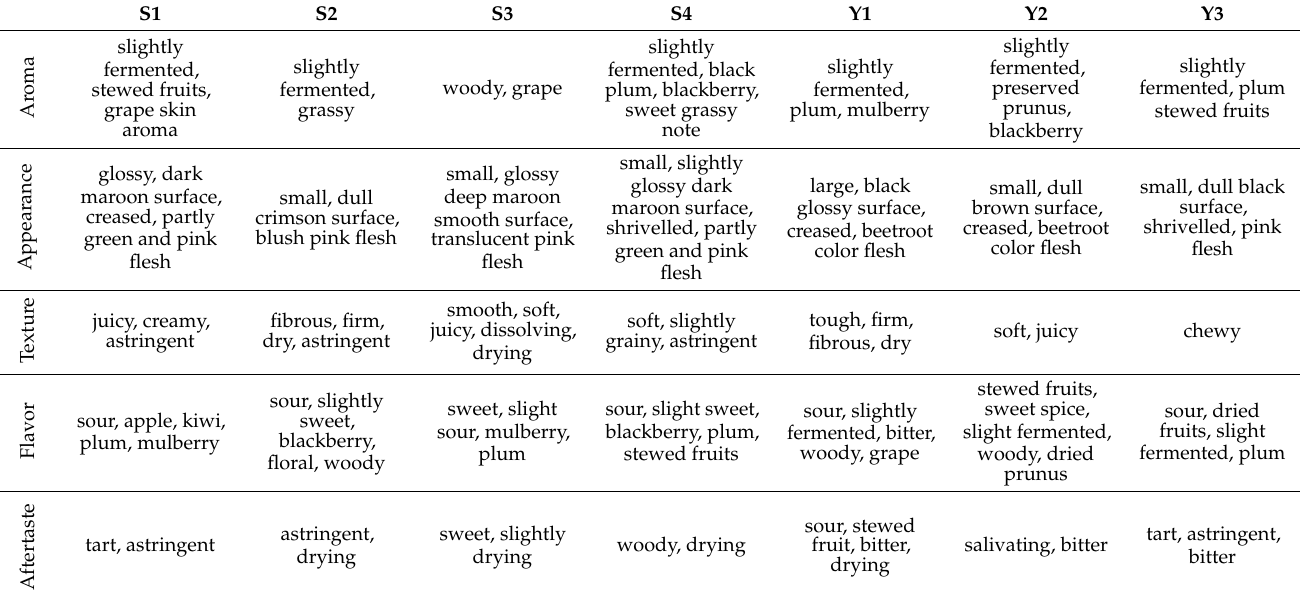
Table 9. Sensory descriptors for the studied BP at the end of storage by consensus of 12